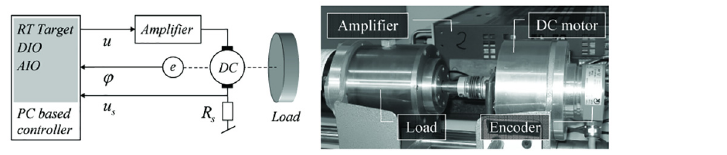
Fig 2. System overview and experimental test